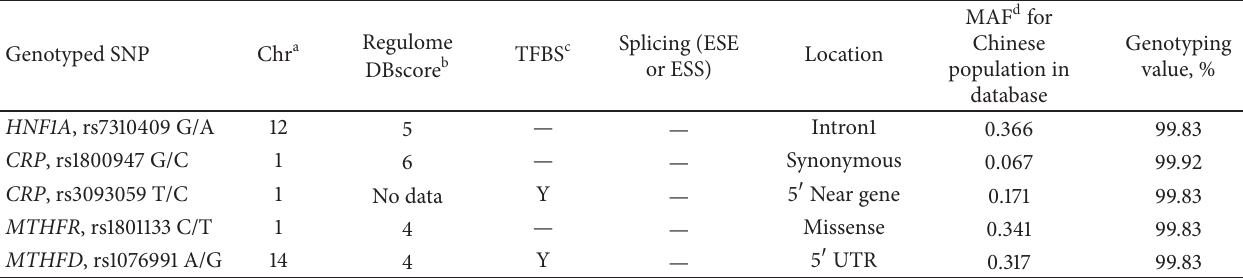
Table 2: Primary information for five genotyped